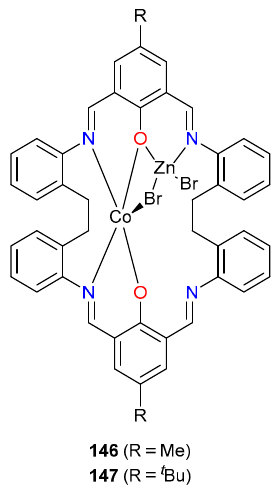
Figure 27. Heterobimetallic macrocyclic complexes 146 and 147 [85].